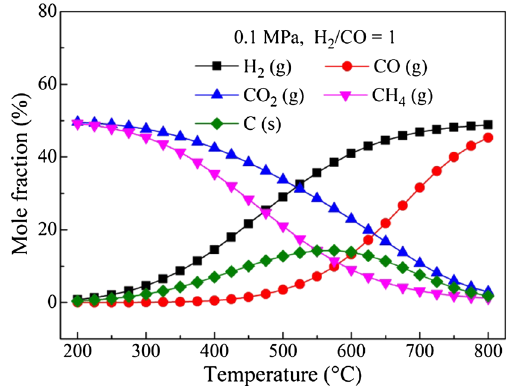
Fig. 2 Equilibrium mole fraction of related substances in RDR reaction